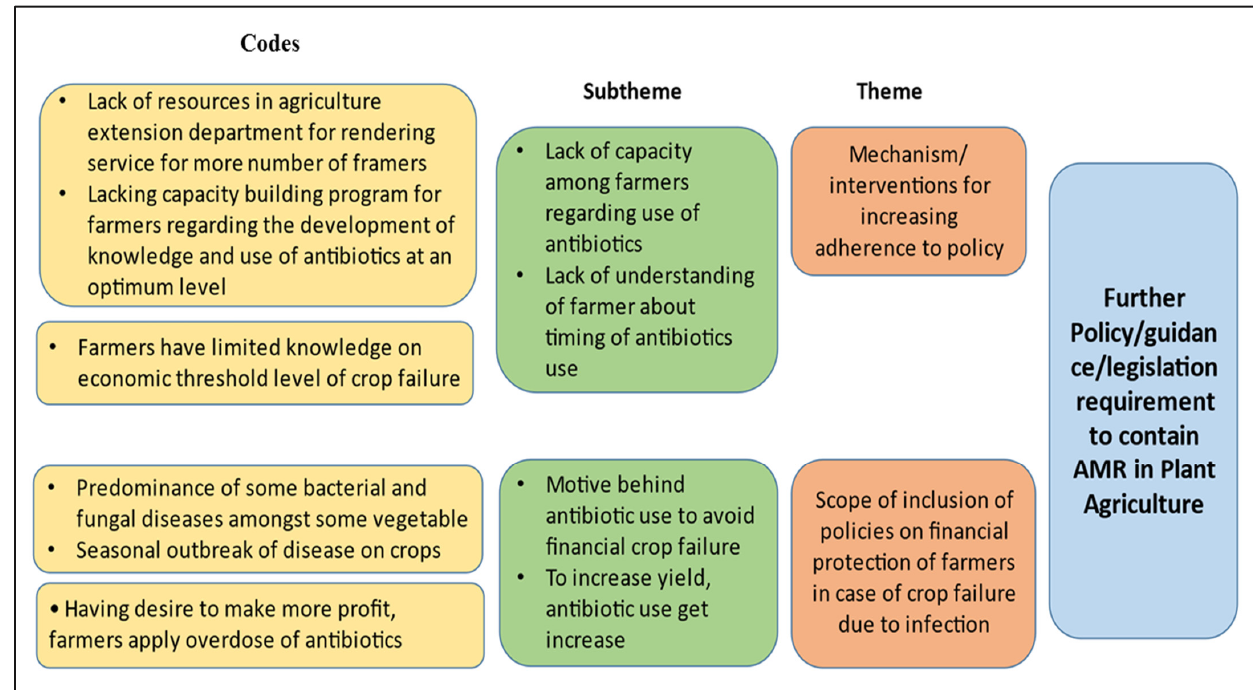
Figure 1. Thematic areas for intervention in plant/agricultural sector.